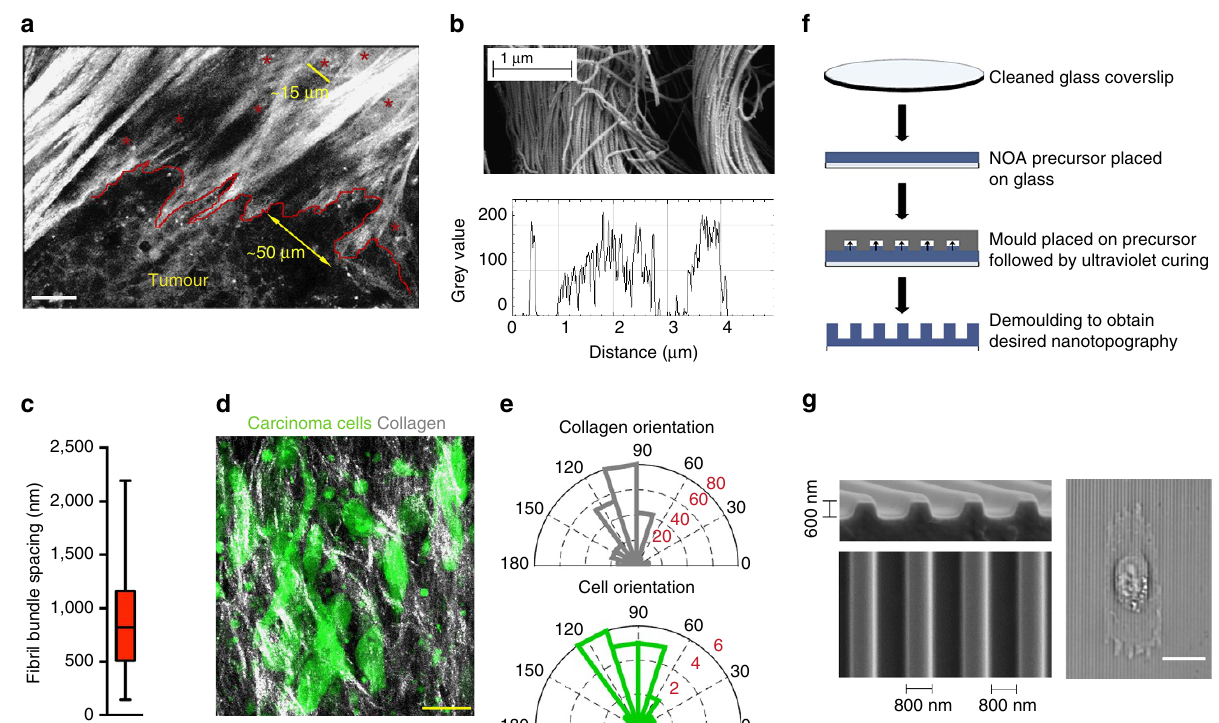
Figure 1 | Nanopatterned substrates mimic aligned collagen architectures in breast and pancreas cancer. ( a ) Combined multiphoton excitation (MPE) and SHG image from live mammary carcinoma adapted from Provenzano et al. 16 , with permission, demonstrating the distinct cell–ECM interactions present during carcinoma cell invasion into regions of aligned stromal collagen. Asterisks signify single cells that have migrated past the tumour boundary along aligned collagen fibres. Scale bar, 25 m m. ( b ) SEM image of collagen fibrils within mammary collagen fibres and line scan data demonstrating the spacing between fibril bundles. ( c ) Quantification of the mean and full range (bars) of spacings between fibril bundles. ( d ) Combined MPE and SHG imaging showing aligned collagen patterns (grey) interacting with ZsGreen expressing PDA cells (green) within a pancreas tumour. Scale bar, 50 m m. ( e ) Angular histogram of orientation of collagen and carcinoma cells from the image in d showing cell elongation in the direction of collagen alignment. ( f ) Step-wise methodology for nanofabrication of substrates to model ECM alignment. ( g ) Scanning electron micrograph of the standard aligned substrate possessing ridge and groove widths of 800nm and ridges that are 600nm in depth and a micrograph showing a typical MDA-MB-231 cell on a typical aligned substrate oriented along the direction of ECM alignment. Scale bar, 20 m